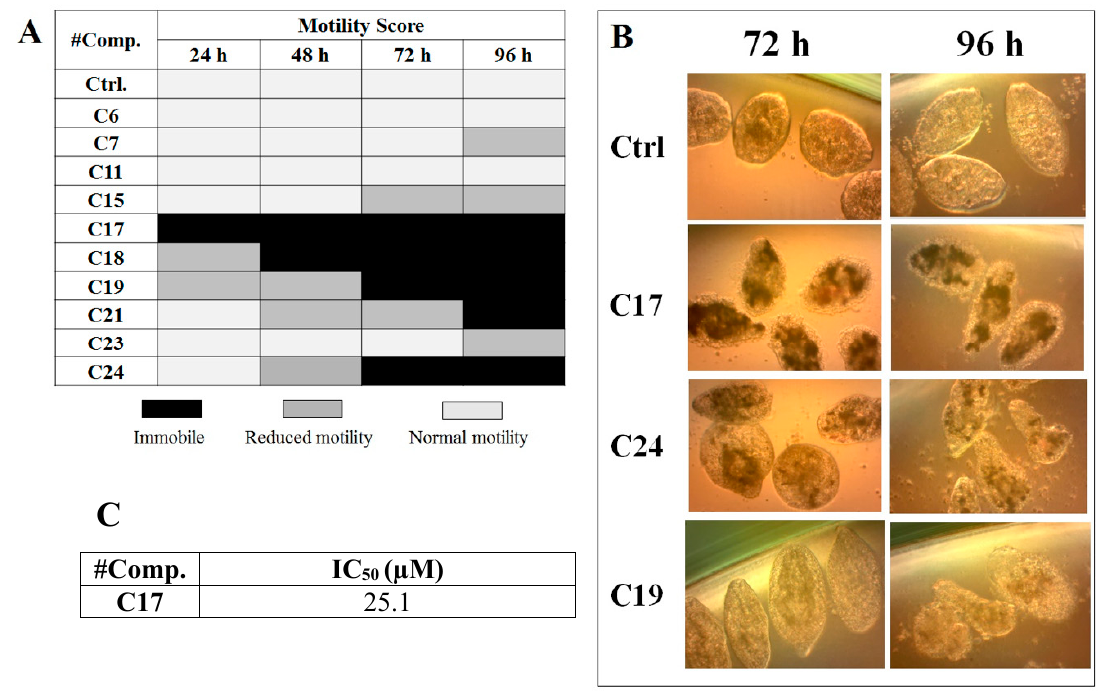
Figure 3. E ff ect of the cathepsin inhibitors against F. hepatica NEJ cultured in vitro. ( A ) Color chart showing the motility score of NEJ incubated with 50 µ M of compound over 96 h. NEJ were classified in three-movement categories (taken from [32]: light gray = normal motility; gray = reduced motility (sporadic movement); black = immobile (dead). ( B ) Microscopic appearance of parasites incubated with 50 µ M of C17 , C24, and C19 at 72 and 96 h treatment. Control NEJ were incubated in 0.5% DMSO.